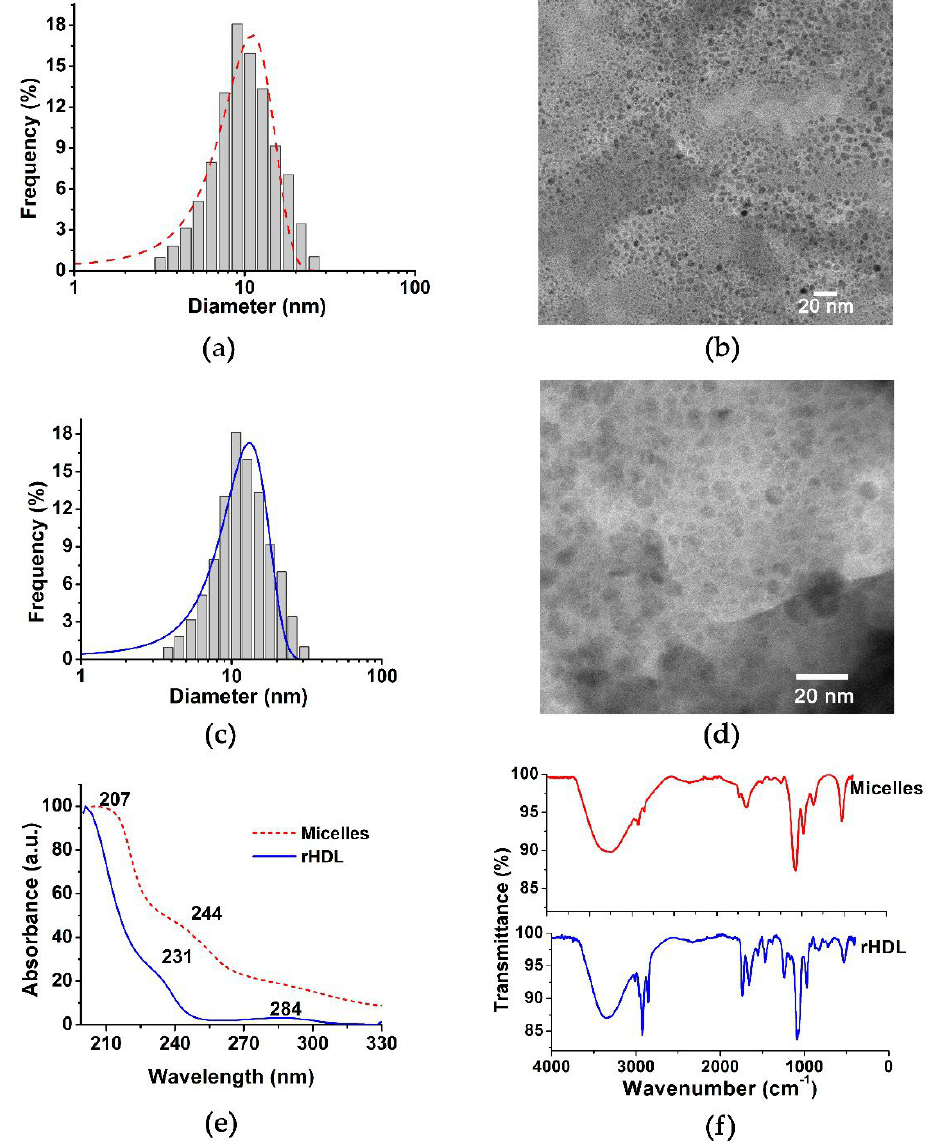
Figure 2. ( a ) Size distribution of lipid micelles by DLS, ( b ) TEM micrographs of lipid micelles, ( c ) size distribution of rHDL by DLS, ( d ) TEM micrographs of rHDL, ( e ) UV-Vis spectra of lipid mi- celles (red) and rHDL (blue), and ( f ) FT-IR spectra of lipid micelles (red) and rHDL